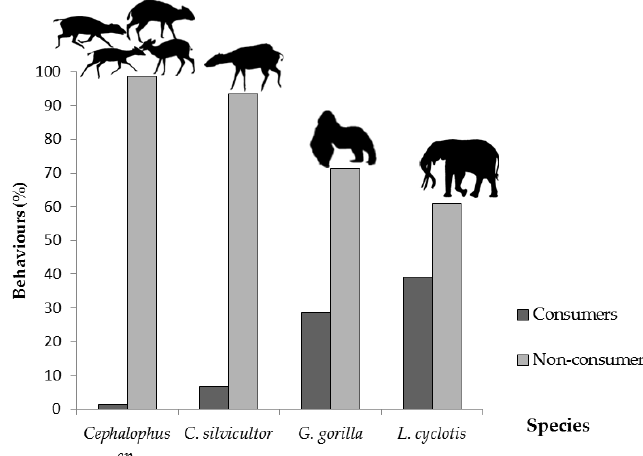
Figure 5. Distribution of behavior for each species of interest.